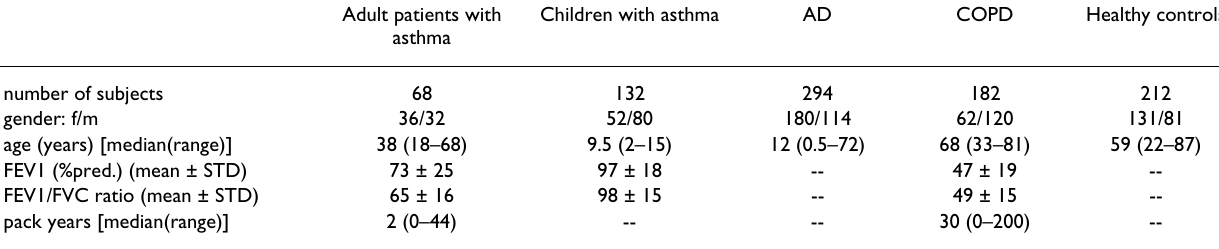
Table 1: Clinical data of the asthma, AD and COPD cohorts as well as the control group